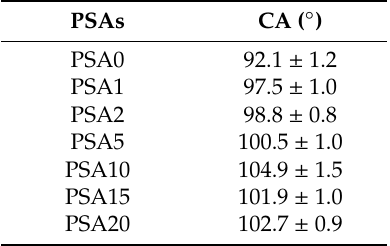
Table 4. Contact angle of di ff erent PSAs copolymers.